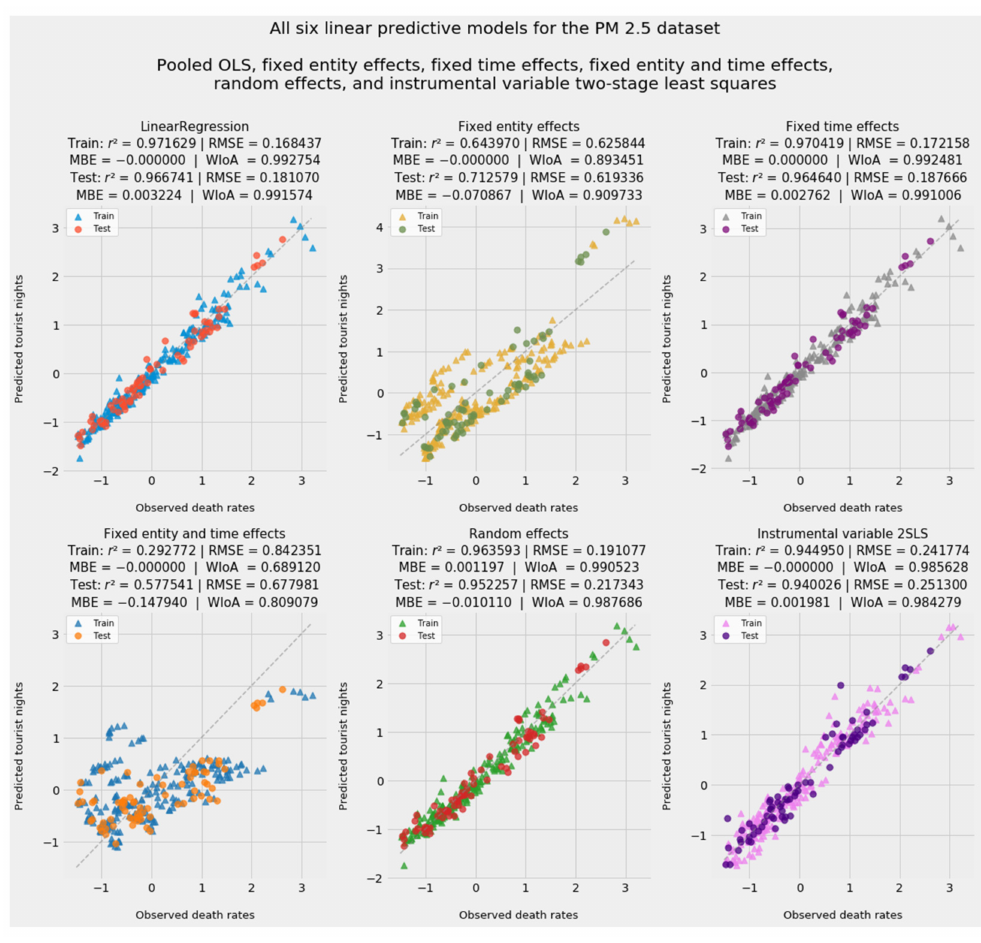
Figure 2. Fitted values and accuracy statistics for all linear